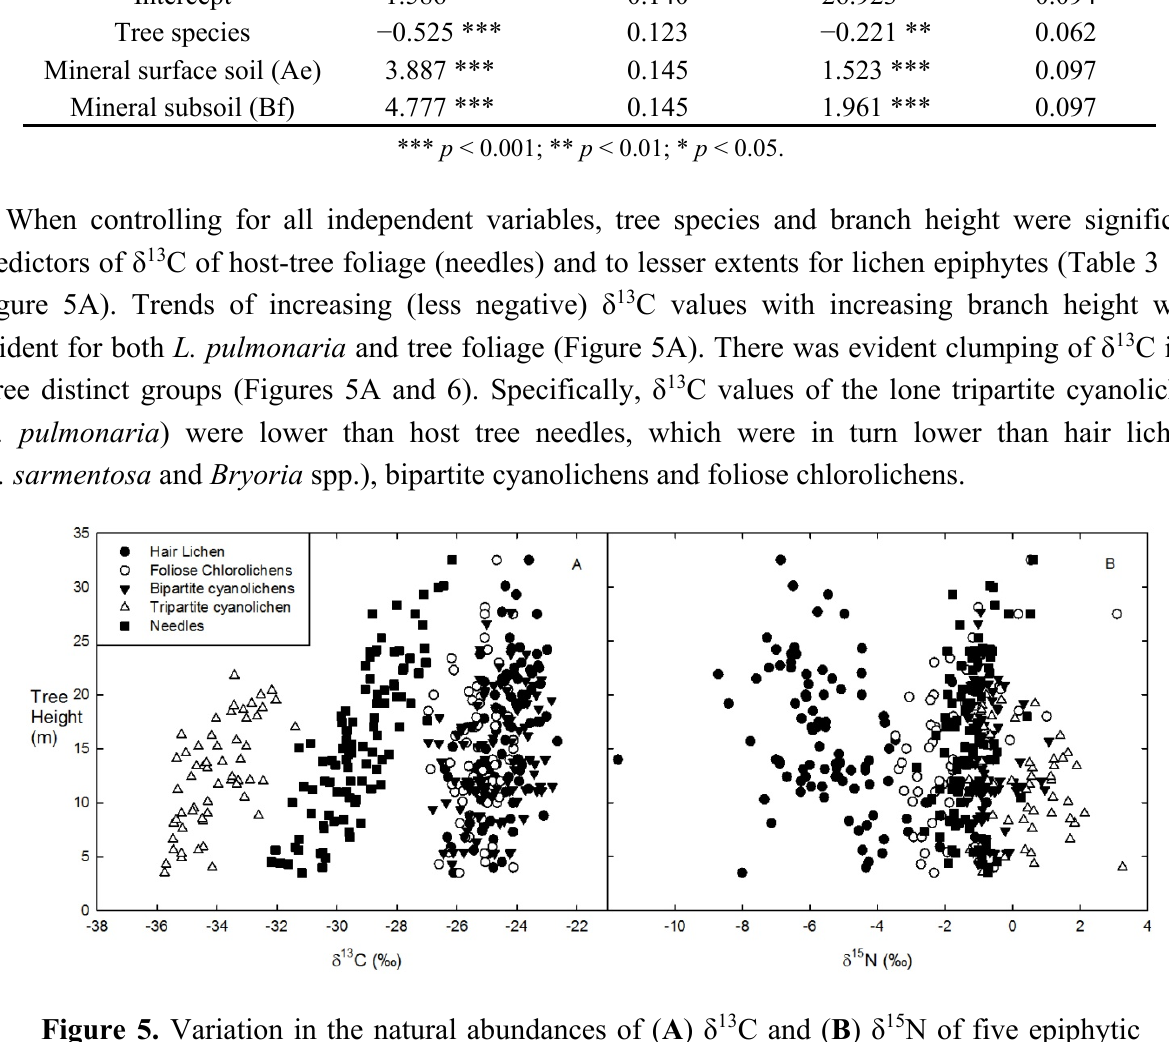
Figure 5. Variation in the natural abundances of ( A ) δ 13 C and ( B ) δ 15 N of five epiphytic lichen functional group and host tree foliage (needle) biomasses according to tree branch height for all